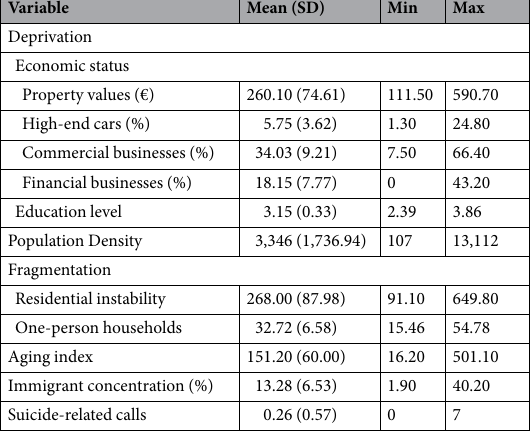
Immigrant concentration. This was measured as the percentage of immigrant population in each census block group.